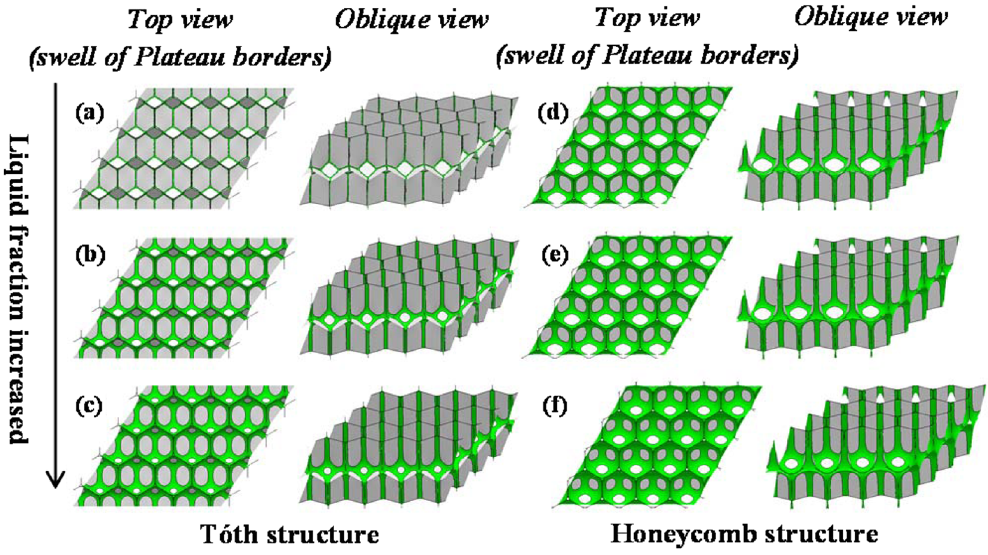
Figure 10. The configurations of two kinds of bilayer monodisperse foam structure with the variation of liquid fraction ϕ liq : Tóth structure: ( a ) 0.1%; ( b ) 1.0%; ( c ) 2.0%. Honeycomb structure: ( d ) 2.0%; ( e ) 3.0%; ( f )